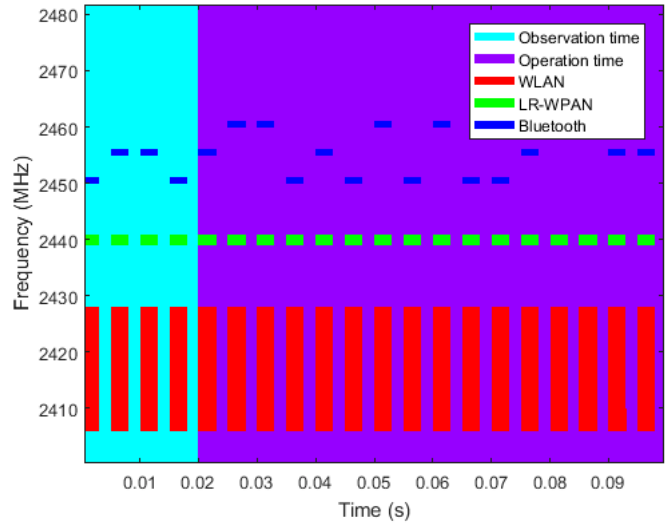
Figure 13. Representation of observation (blue) and operation (purple) times and example of channel occupancy with two static networks (WLAN and LR-WPAN) and a dynamic network (Bluetooth) that hops over three frequency channels. The coexisting networks will be analysed during the observation time to determine the operation of the network of interest during the operation time.